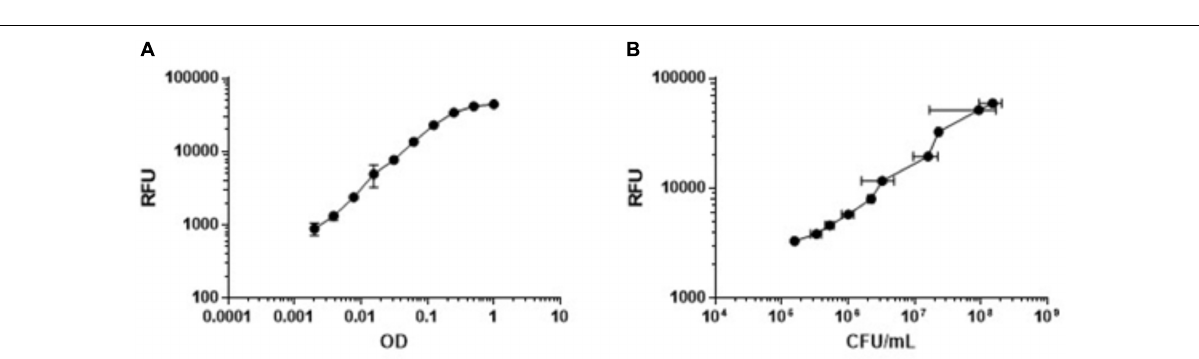
FIGURE 1 | Final assay plate layout. Column 1 contains positive control (Niclosamide) in Rows A–D and negative control (DMSO) in Rows E–H. Column 12 contains bacteria-free control wells. Compounds are tested in Rows A–G as 10-pt serial twofold dilutions. Row H contains a control twofold dilution of niclosamide starting at 25 µ M in Column 2.